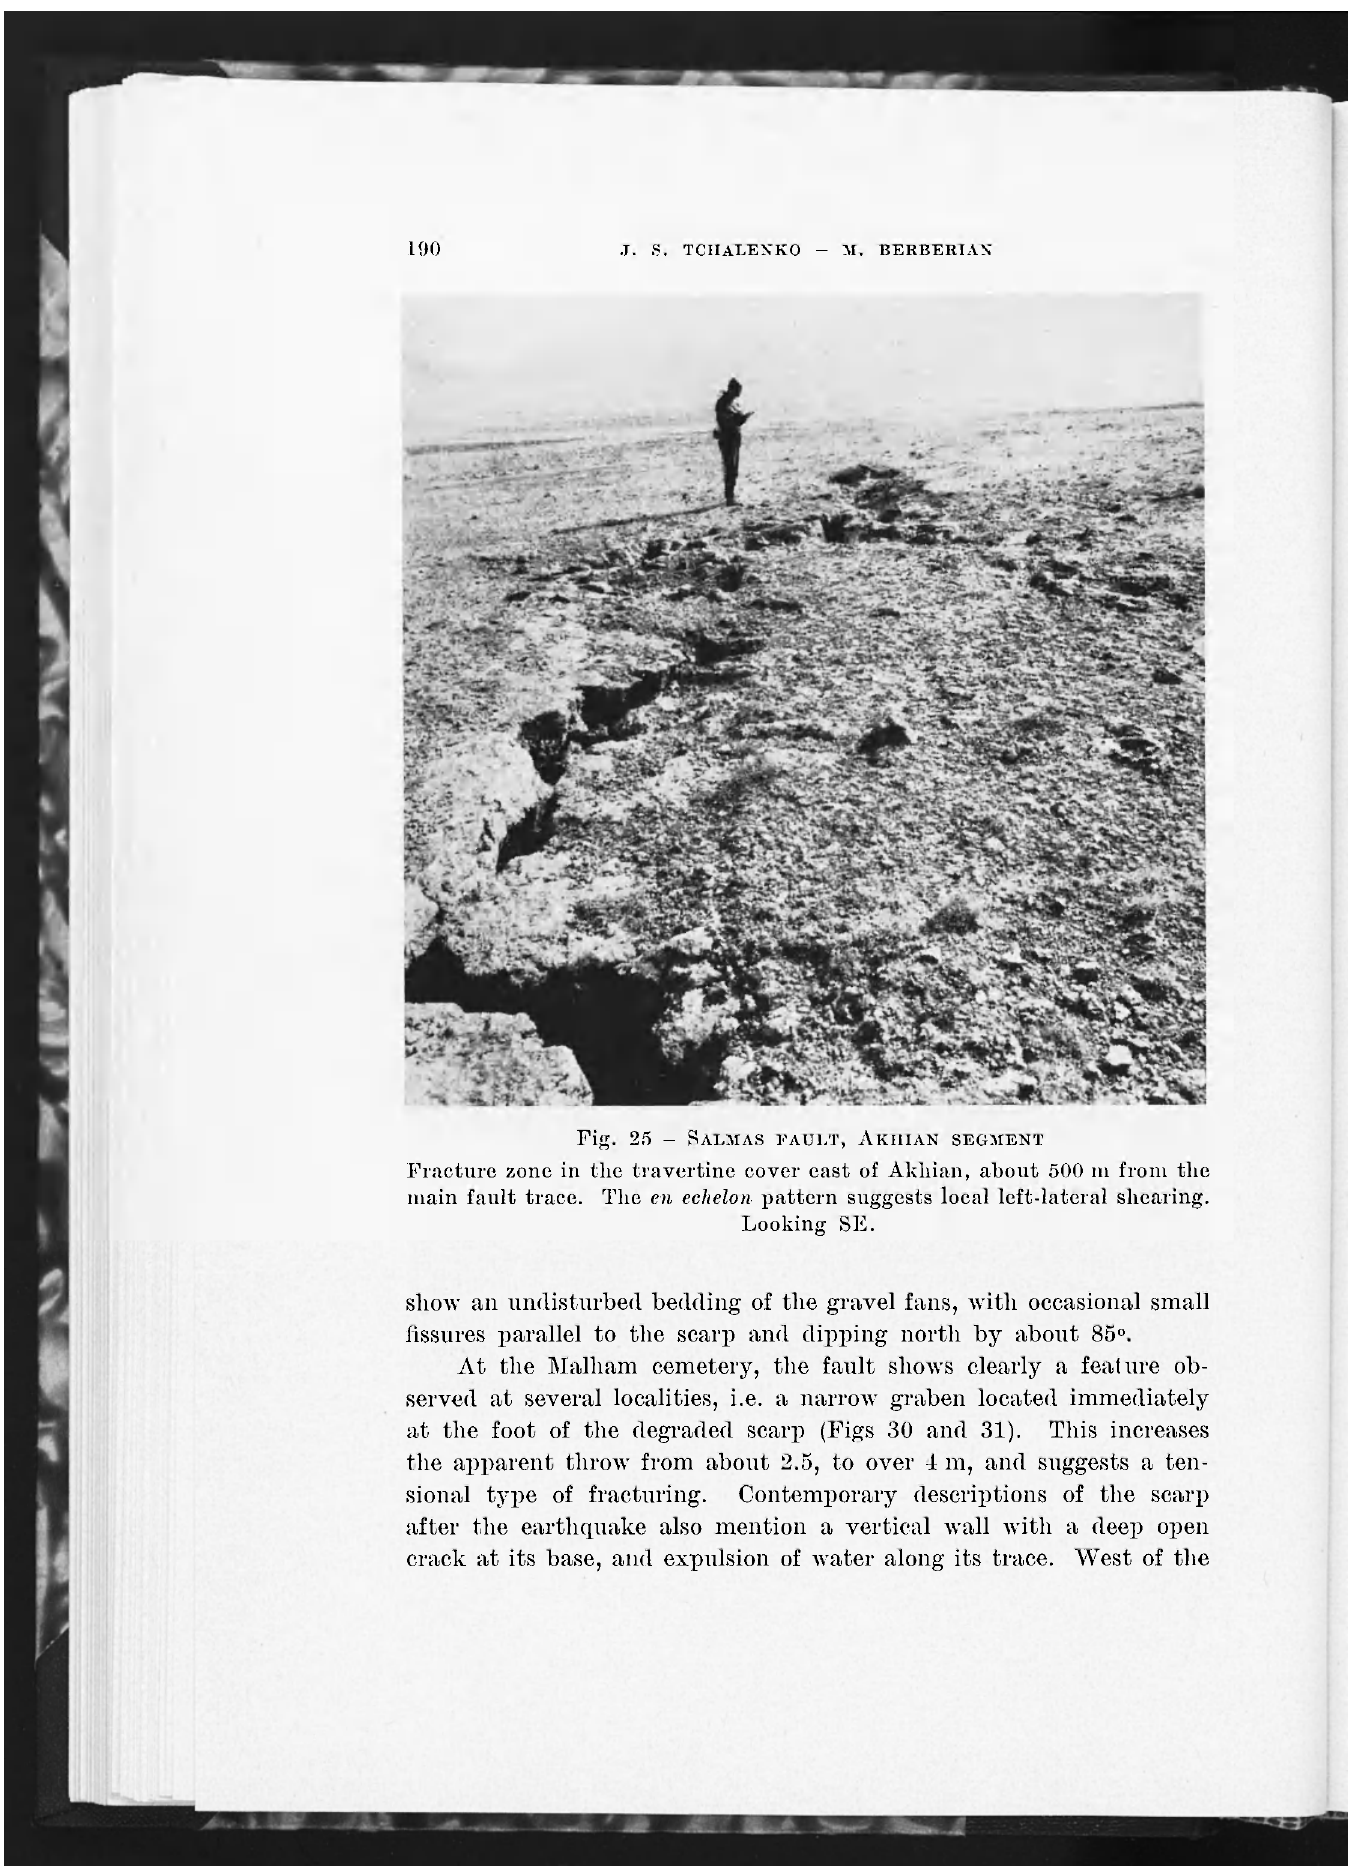
Fig. 25 - SALMAS FAULT, AKIIIAN SEGMENT Fracture zone in the travertine cover east of Akiiian, about 500 m from the main fault trace. The en echelon pattern suggests local left-lateral shearing. Looking